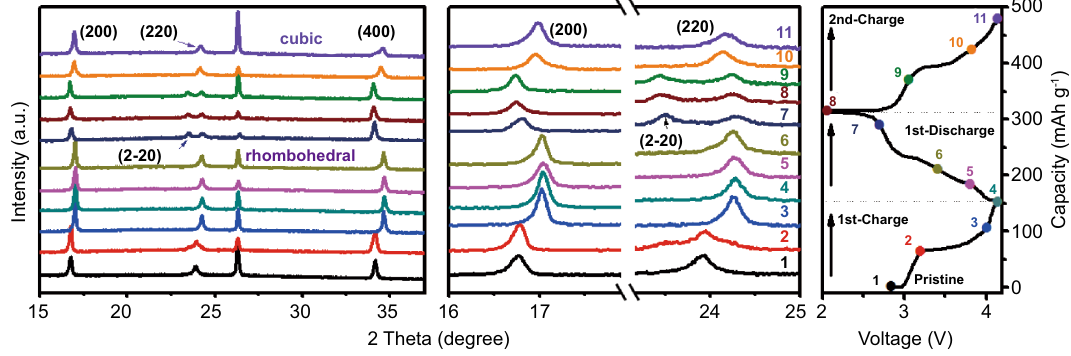
Fig. 6 Ex situ XRD patterns of FeHCF-I during the charge–discharge